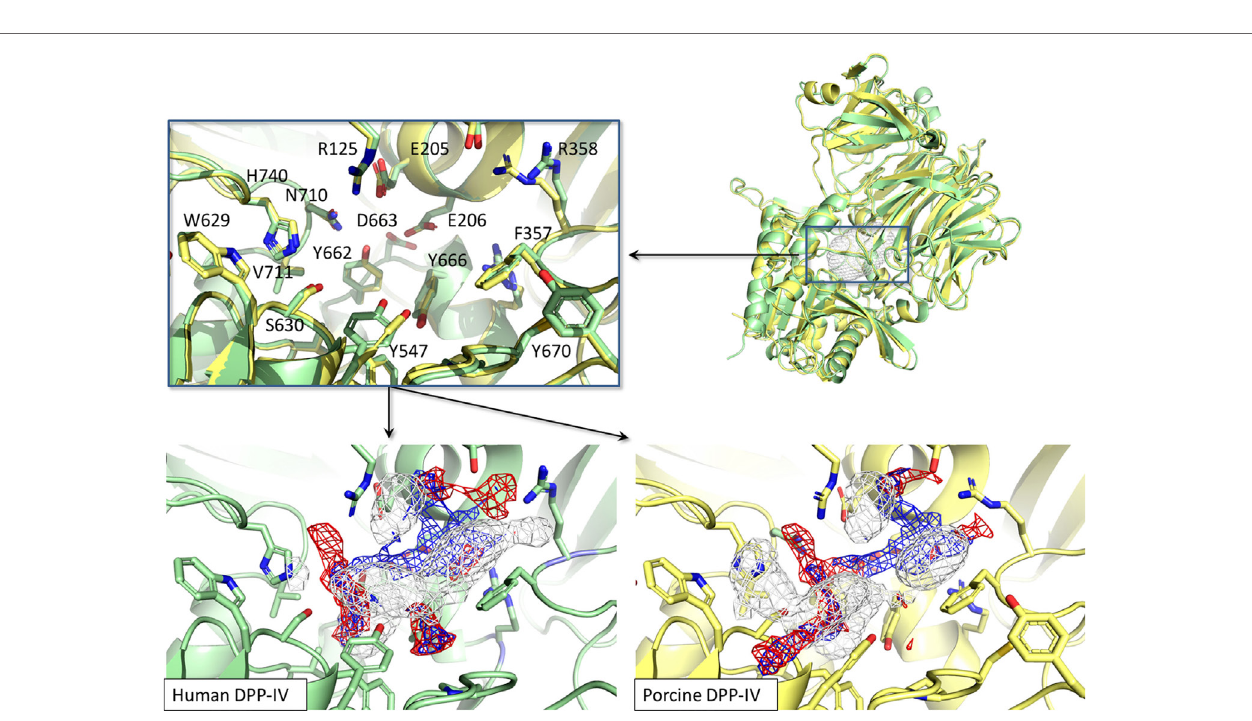
FigUre 8 | Structural and pharmacophorical comparison between porcine [PDB ID 1ORW (26)] and human [PDB ID 1WCY (37)] dipeptidyl peptidase IV (DPP-IV). Proteins are represented in cartoon while amino acids constitutive of the binding site are represented in sticks. The white, blue, and red meshes identify regions sterically and energetically favorable for hydrophobic, hydrogen bond donor and hydrogen bond acceptor groups, respectively.